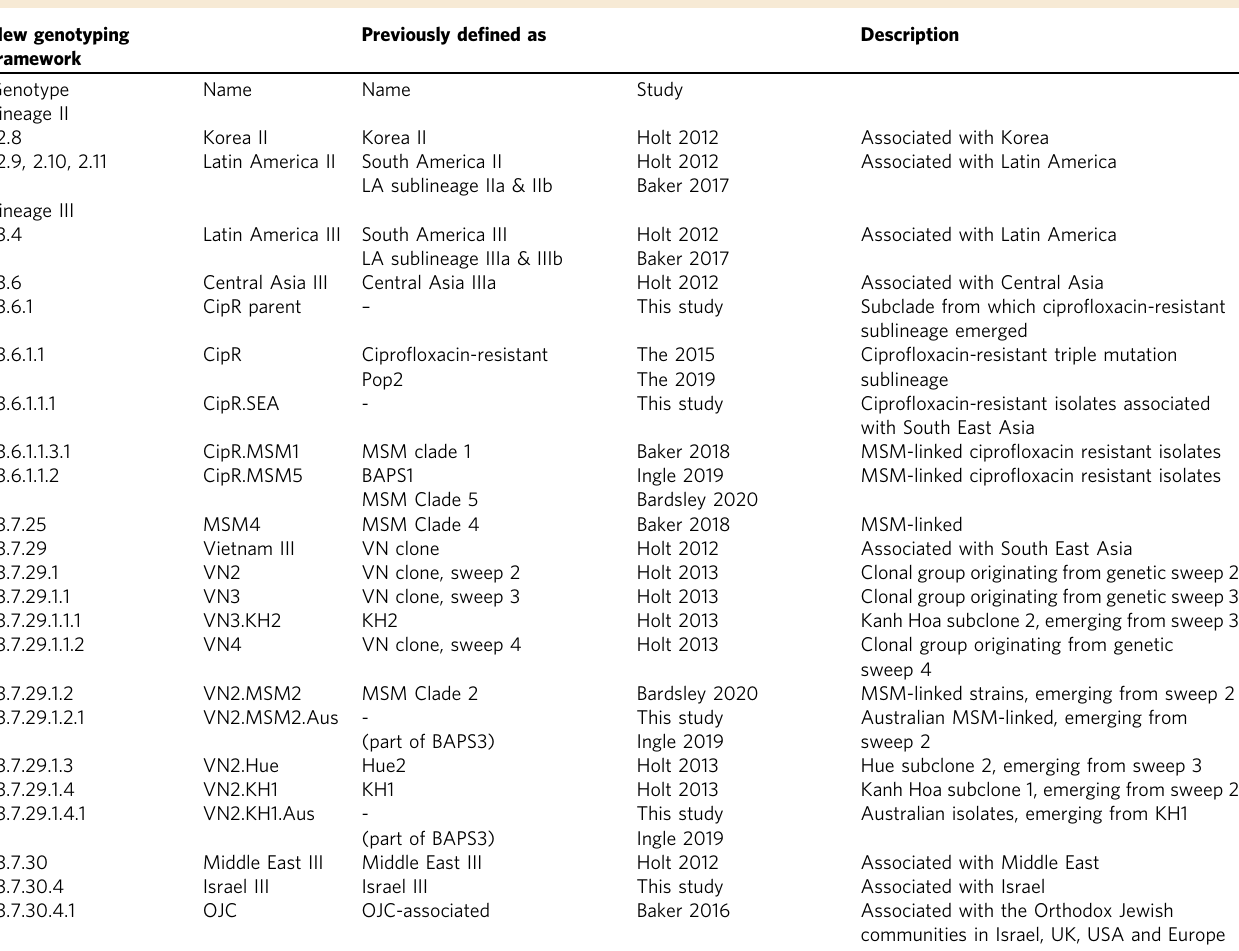
Table 2 Details of epidemiological clusters de fi ned within the S. sonnei population. New genotyping